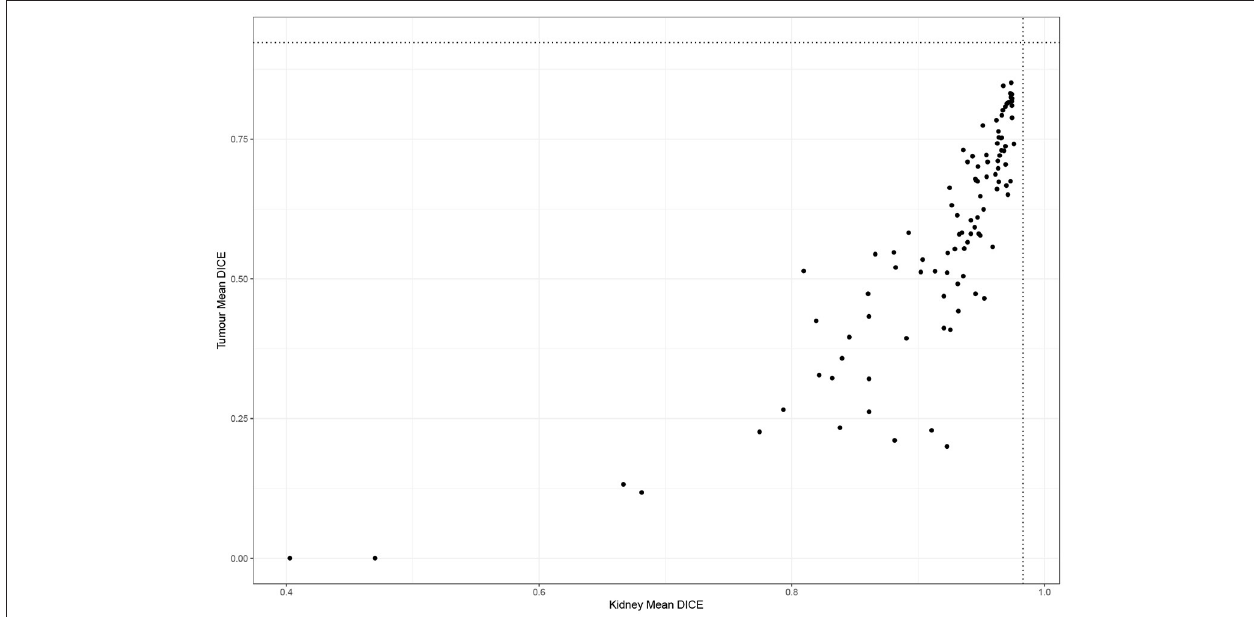
FIGURE 2 | Performance of participating teams in segmenting the kidney and tumor (dotted lines represent inter-observer agreement for kidney and tumor segmentation).